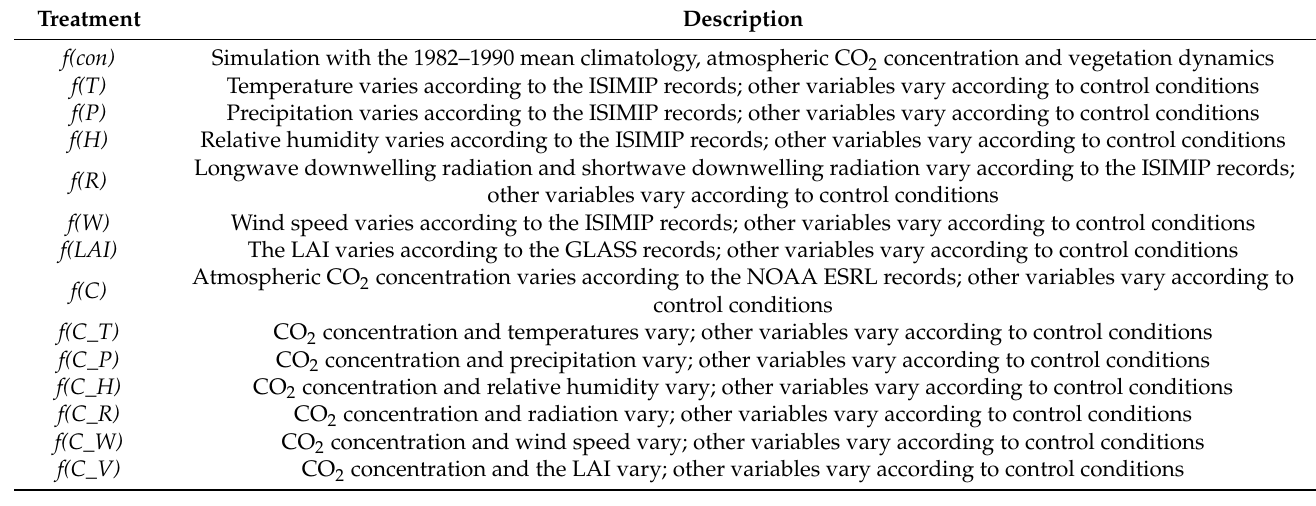
Table A1. Summary of simulation